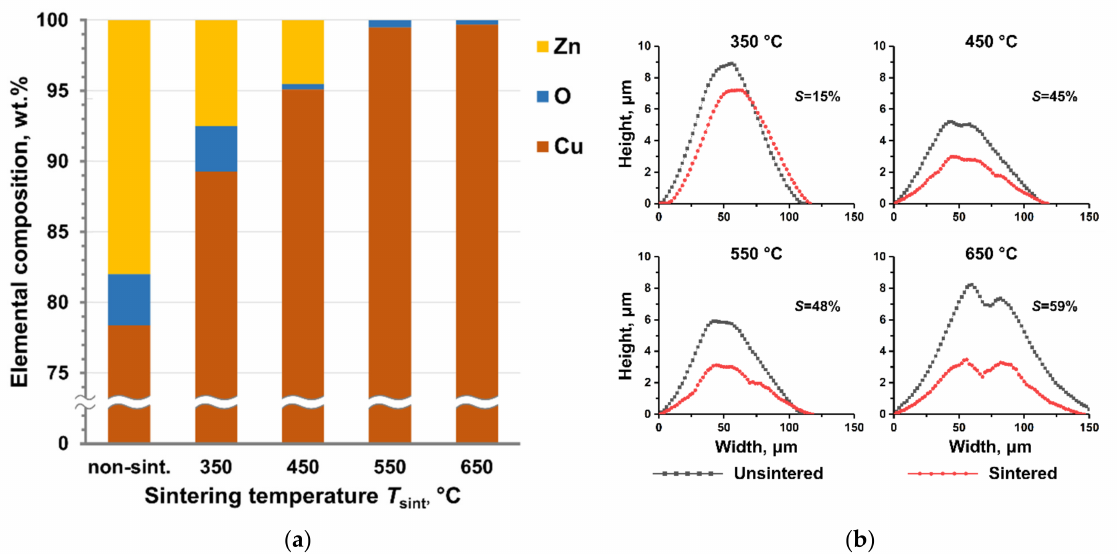
Figure 6. ( a ) Changes in the elemental composition (results of EDX analysis) and ( b ) the cross-sectional profile of lines based on copper nanoparticles with the temperature of reductive on alumina substrate as an example.